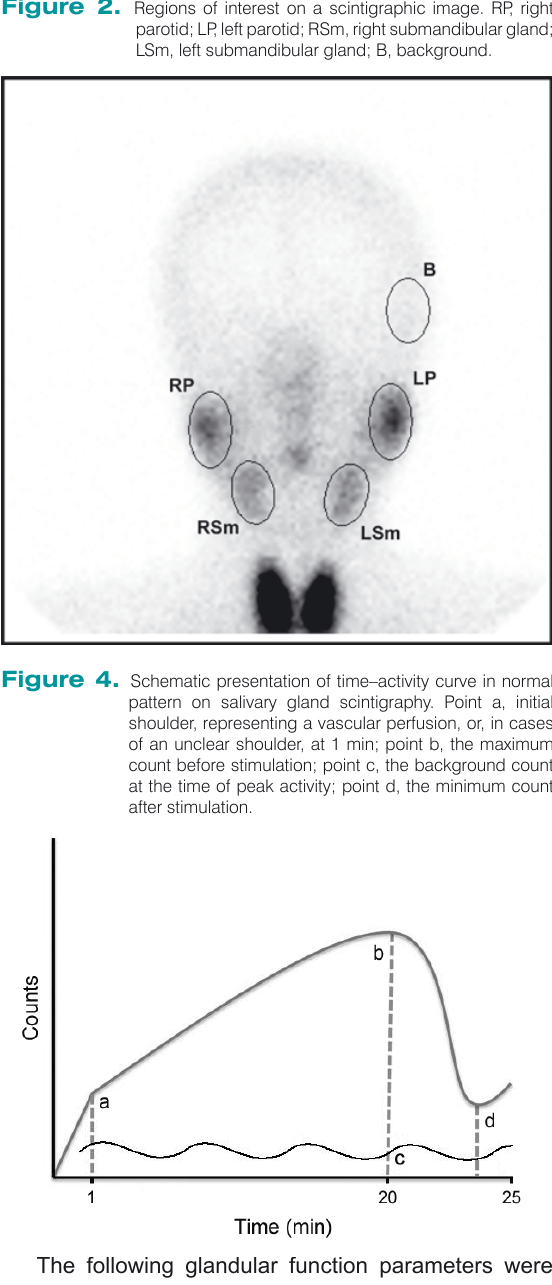
Figure 3. Time-activity curves of parotid and submandibular glands.